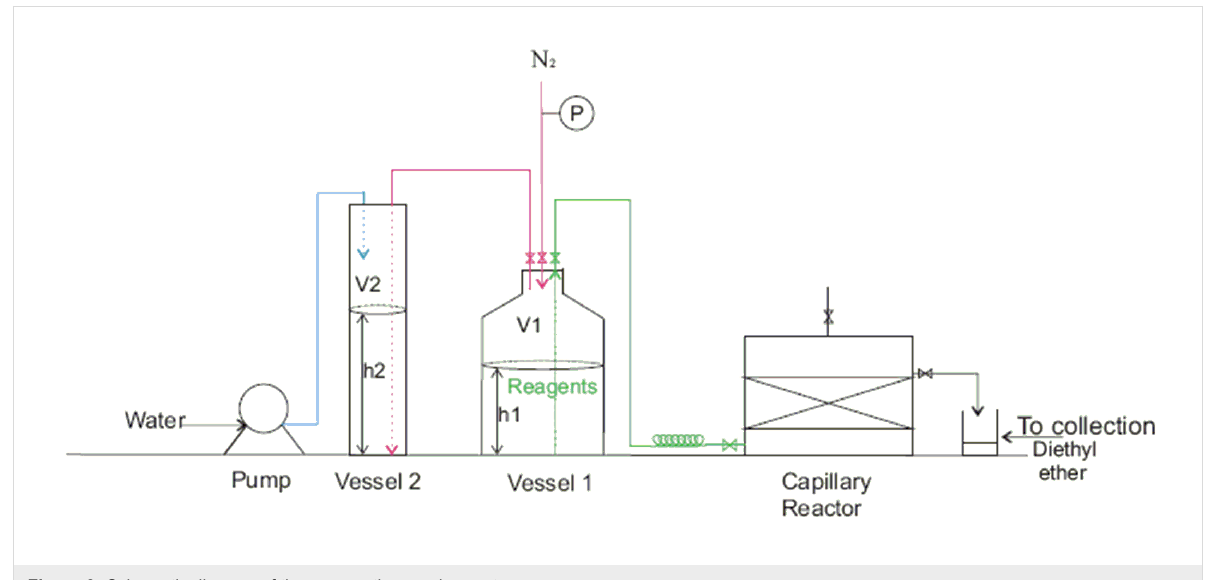
Figure 3: Schematic diagram of the pneumatic pumping system.